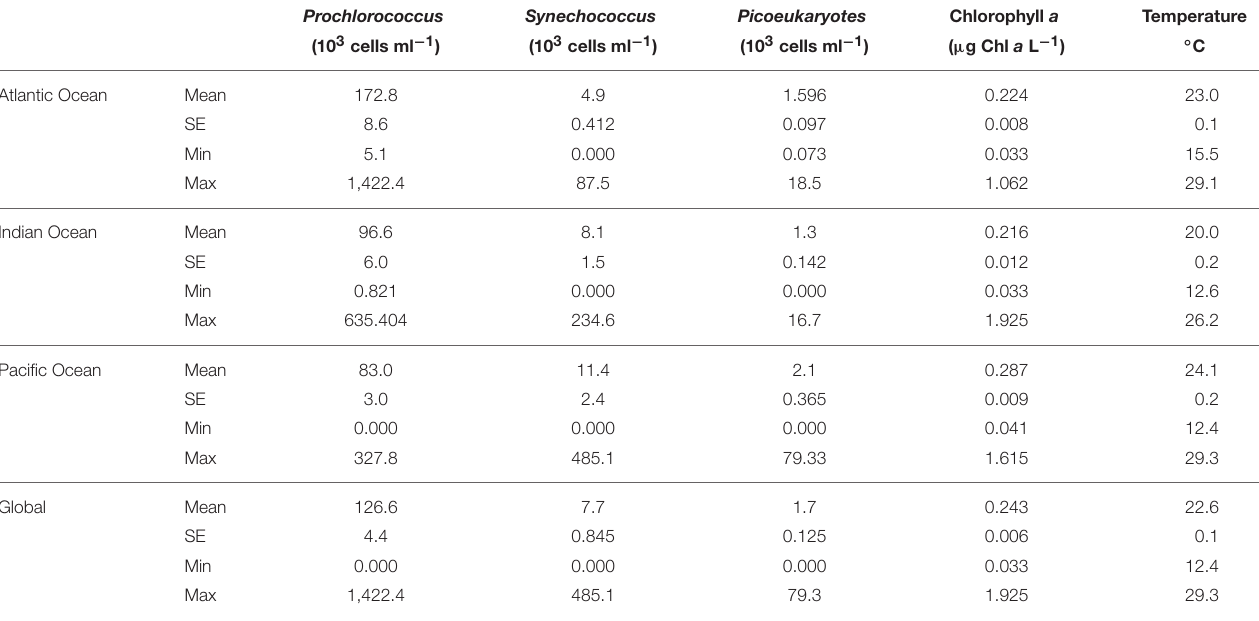
TABLE 1 | Global and per ocean basin mean abundance values of the three groups of pico-phytoplankton: Prochlorococcus ( N = 1259), Synechococcus ( N = 1077), and eukaryotic picoplankton ( N = 1237).